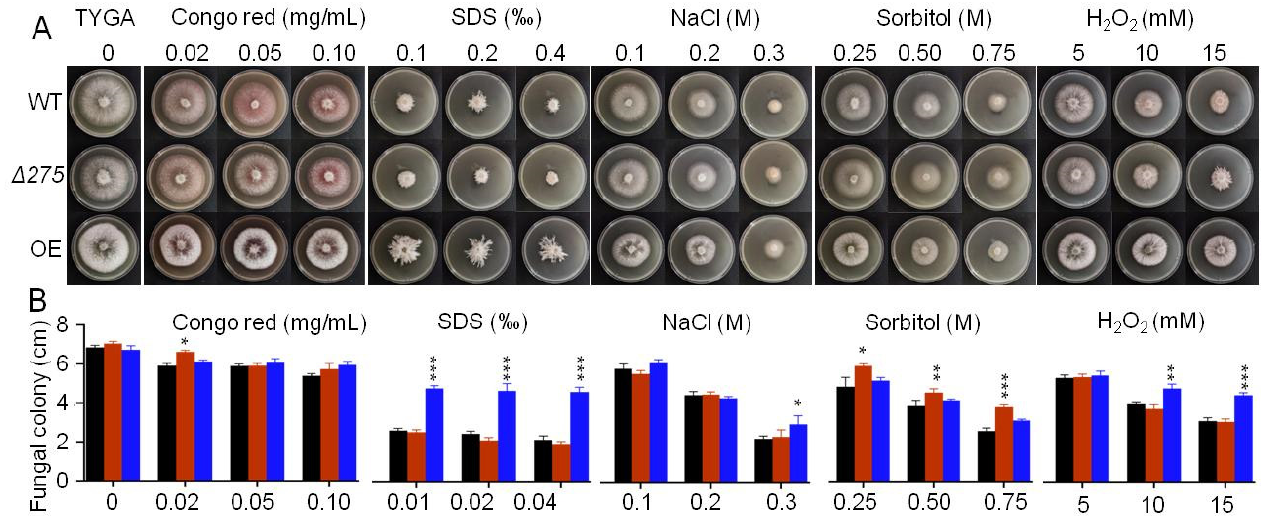
Figure 4. The effects of 275 on the fungal resistances to chemical stressors on TG plates: ( A , B ) Comparison of the colony growth between the two mutants ( Δ 275 and OE- 275 ) and the WT under treatment with Congo red, SDS, NaCl, sorbitol, and the oxidant H 2 O 2 (*: p < 0.05; **: p < 0.01; ***: p < 0.001).